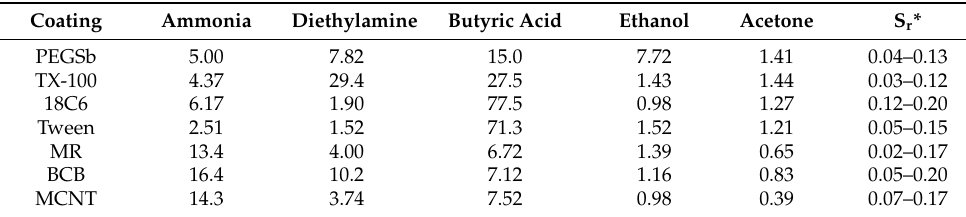
Table 2. Mass sensitivity (S m , Hz · m 3 /g) of selected sensor to VOC and reproducibility of sensor signals in their vapors.